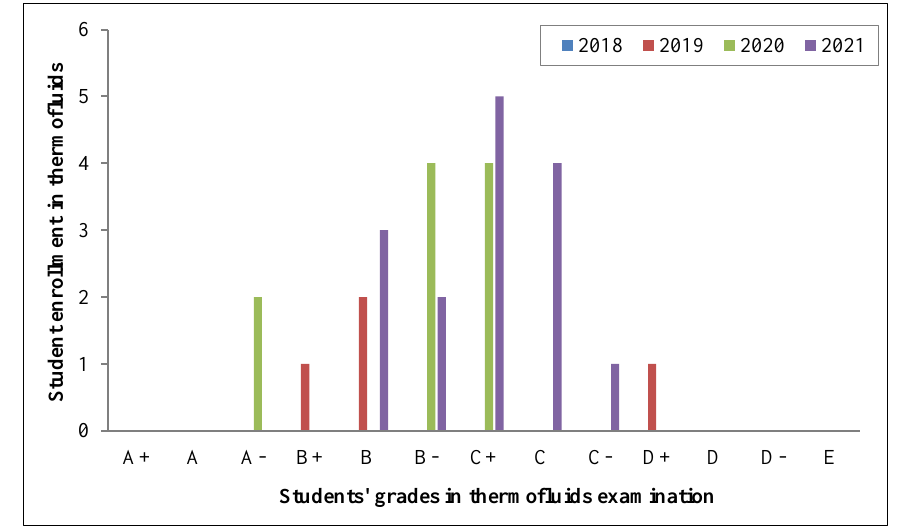
Figure 9. Grade distribution in Advanced Thermofluids course across 4 years 3-2- Normality Tests Results (Preliminary Analysis Results on the Suitability of Parametric/Non-parametric Test) RQ1: Does mode of instruction significantly influence academic performance of engineering students in Fluid